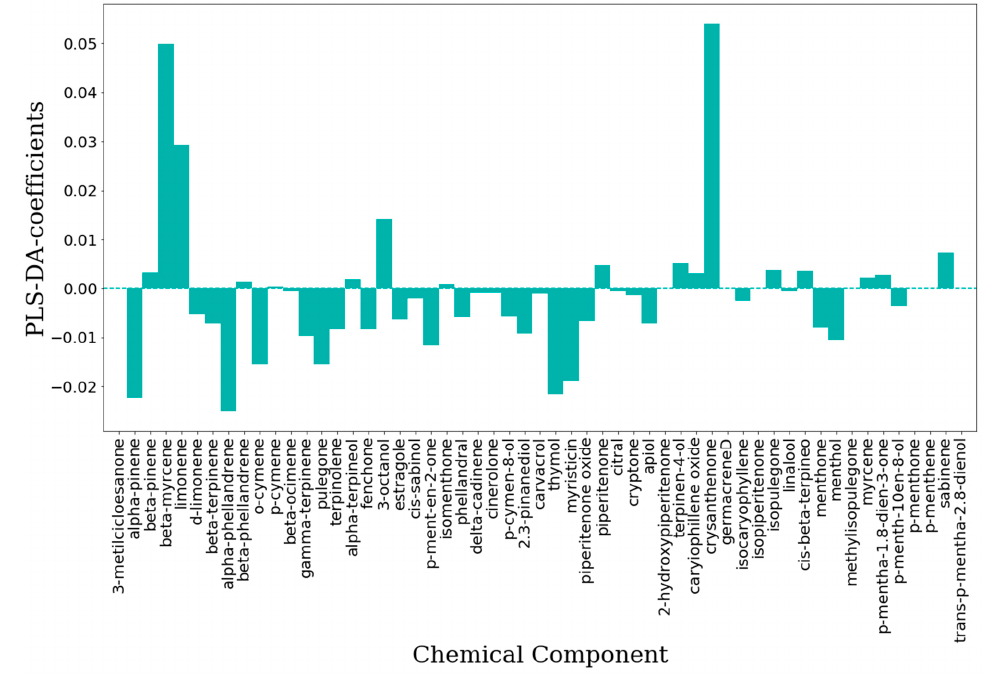
Figure 8. Features importance plot obtained from the IC 50 -PLS-DA classification model. On the